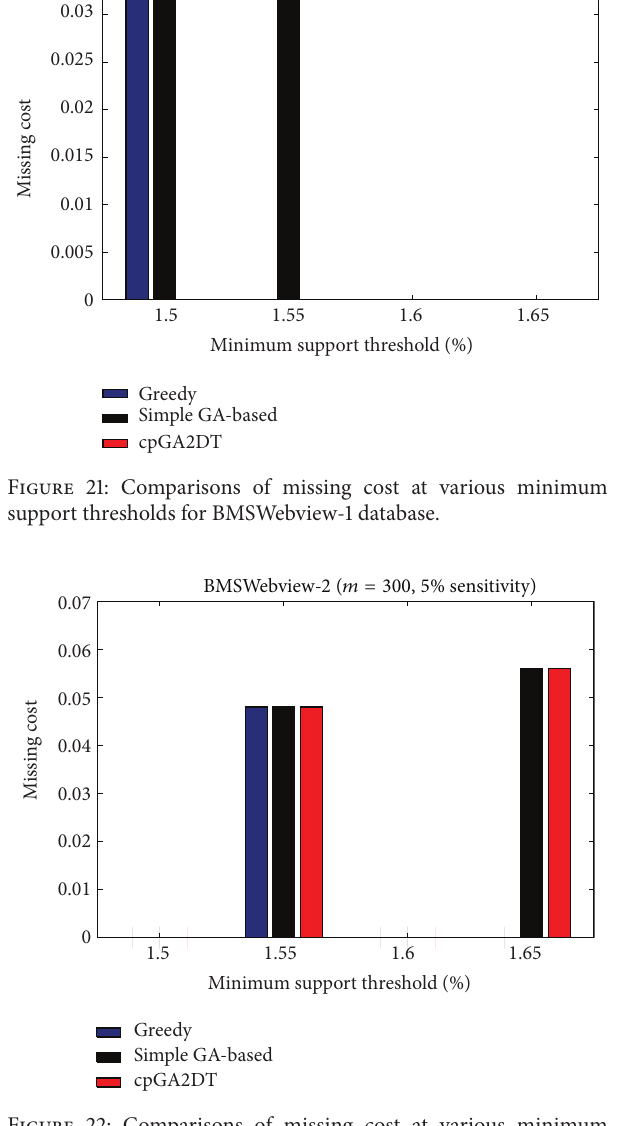
Figure 22: Comparisons of missing cost at various minimum support thresholds for BMSWebview-2